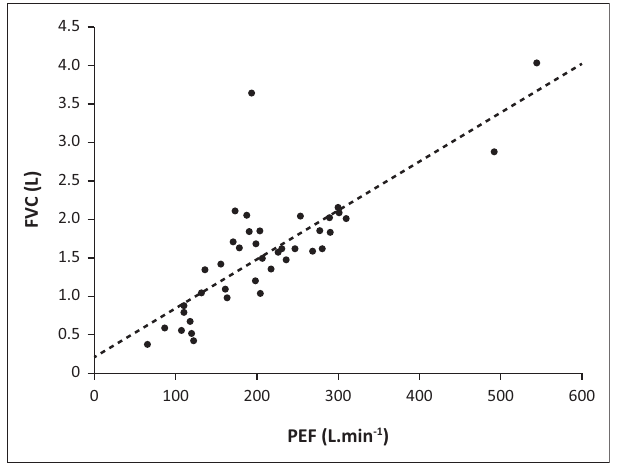
FIG URE 3: Probability plots for peak expiratory flow and forced vital capacity and peak cough flow values of (a), (b) < 160 L.min –1 and (c), (d) < 270 L.min –1 .